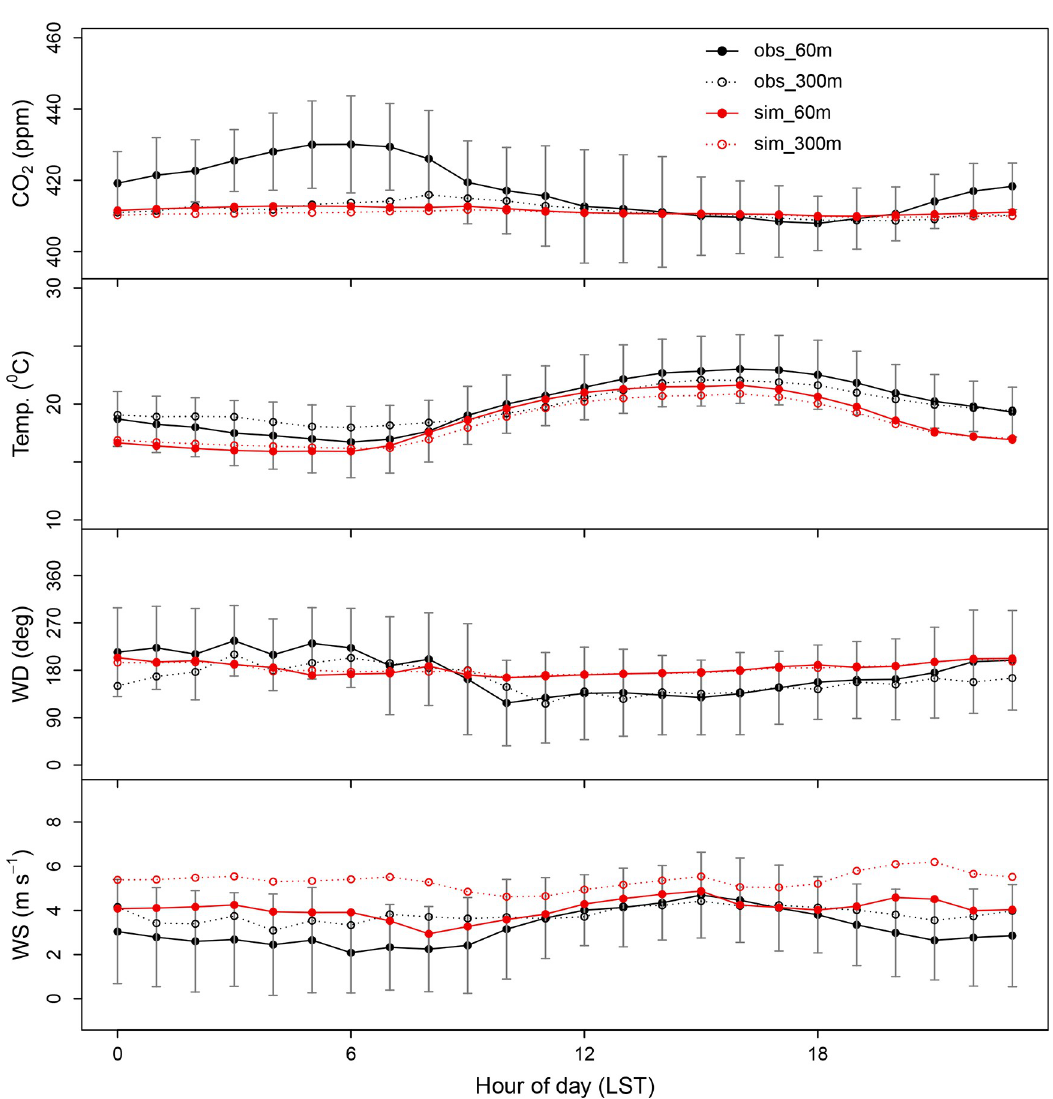
Fig 4. Diurnal variation of CO 2 concentrations and meteorology, observed and simulated, at the flux tower site (BO) at 60 m and 300 m a.g.l. Vertical gray lines indicate 1- σ of observations. space and time at each hourly simulation output. The averaged offset of pressure between the simulated results and the DC-8 observations was ~10 ± 15 hPa in total 18-flight days. In each day of observations, DC-8 took off and flew along planned routes (Fig 1). For the clarity, we divided the aircraft observations into four groups, based on the land cover below the flight tracks and the type of emission sources: SMA, the West (Yellow) Sea, and two main domestic airways in Korea. The SMA represents air quality over the Korean capital city, in which anthropogenic combustion emissions are dominant. The flight tracks over the West (Yellow) Sea were intended to detect the long-range transport of air pollutants from China, where the DC-8 took meridional tracks over the ocean forming a “wall” between China and the Korean Peninsula. The two domestic airways, connecting Seoul to Jeju (J-route) and Busan (B-route), which are the most frequent observation routes that DC-8 took during the study period. The J-